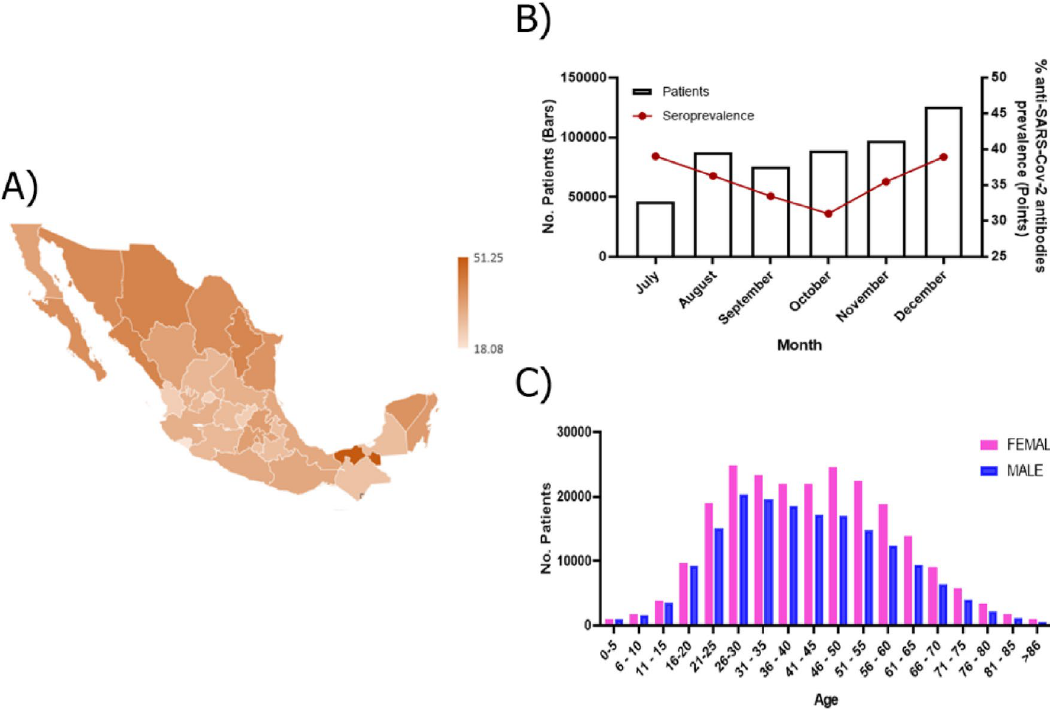
Figure 1. Overview of seroprevalence of SARS-CoV-2 in Mexico. ( A ) Coropletic map shows the anti-SARS- CoV-2 antibodies (IgM and/or IgG) prevalence in Mexico; as the prevalence increases, the brown color becomes darker; ( B ) Temporal trend and monthly seroprevalence to SARS-CoV-2 in 522,690 unvaccinated outpatients from July 5th to December 31st, 2020; ( C ) Distribution of seropositive SARS-CoV 2 cases according to age and sex in 522,690 unvaccinated